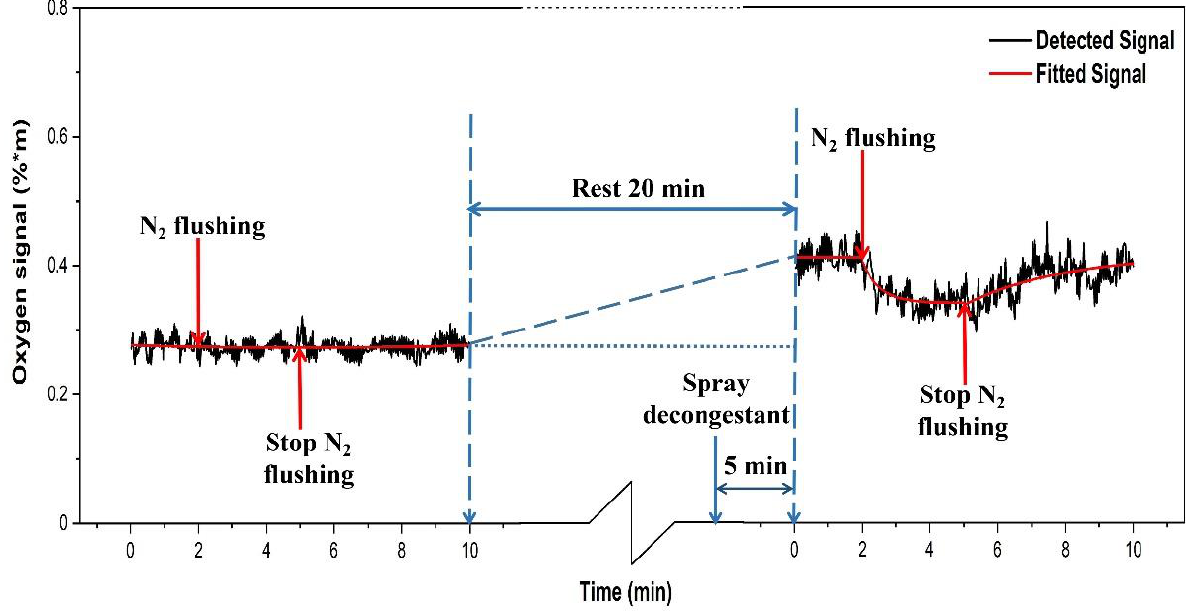
Figure 15. The measured O 2 signal from the left frontal sinus of the rhinitis volunteer. The influence of spraying a decongestant is shown.